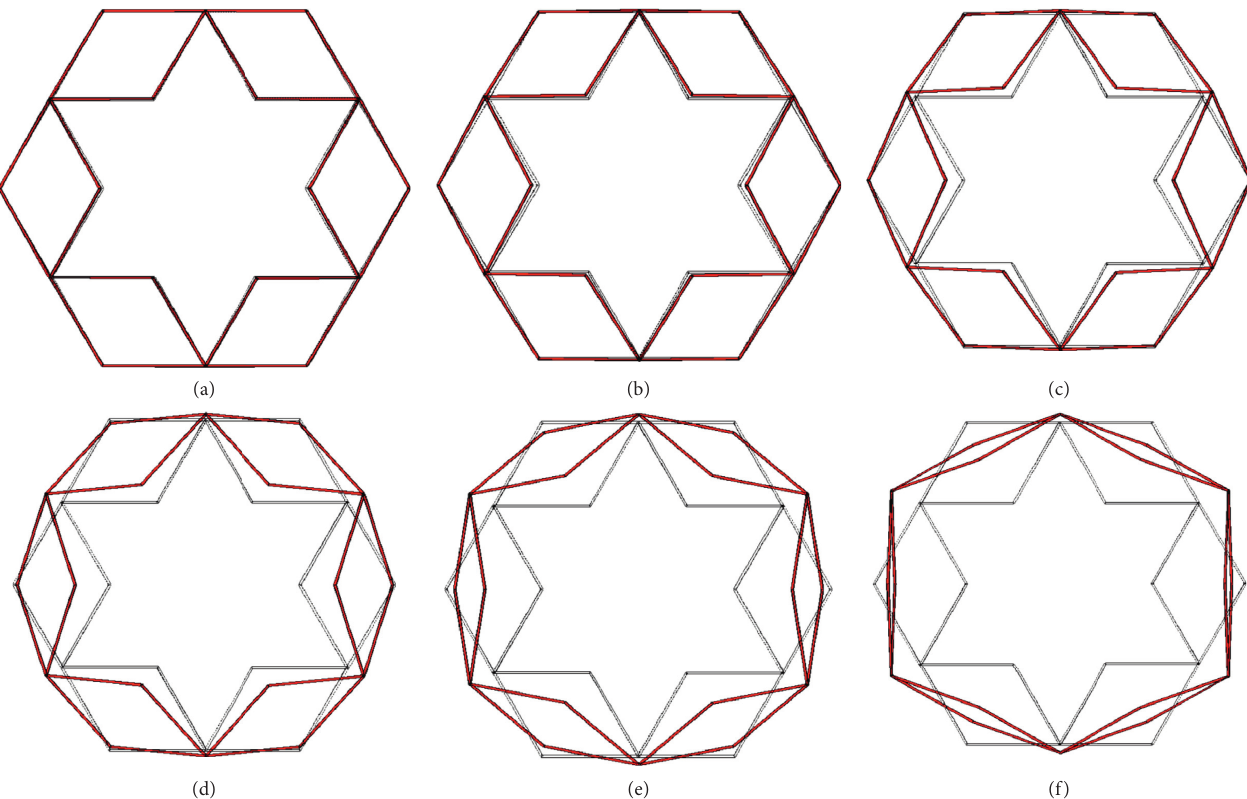
Figure 8: Transformations of mode shapes for the deployable structure during the motion process. (a) Time: 0.2s. (b) Time: 0.6s. (c) Time: 1s. (d) Time: 1.4s. (e) Time: 1.8s. (f) Time: